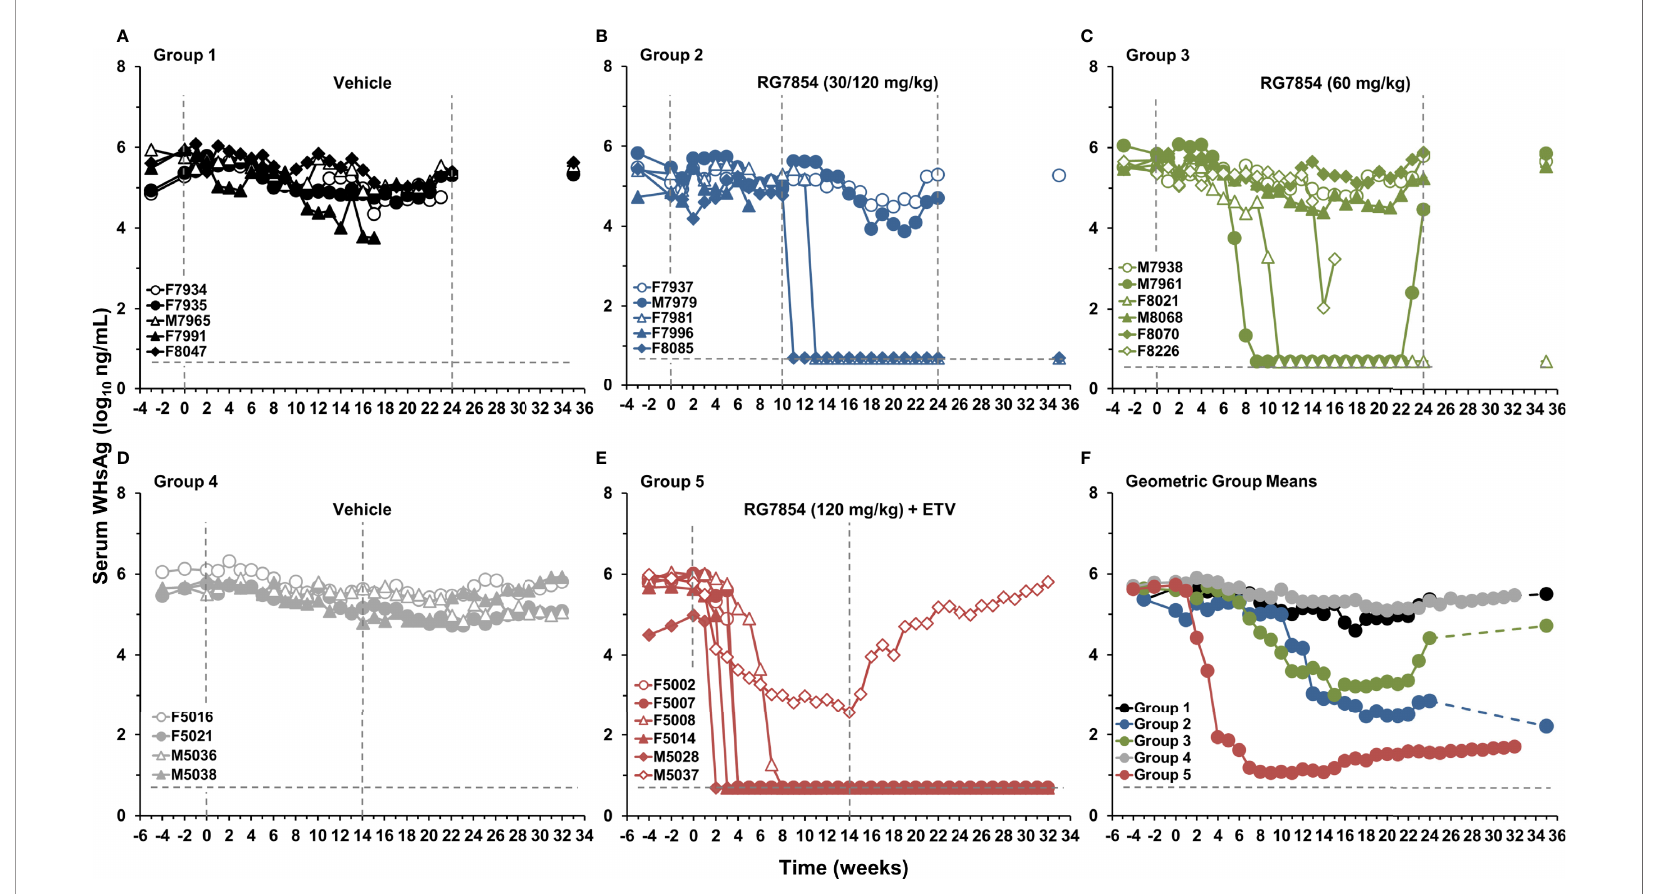
FIGURE 3 | Effect of RG7854, alone and together with ETV, on serum surface antigenemia levels. Kinetics of WHsAg load in individual woodchucks administered (A) placebo or RG7854 at doses of (B) 30/120 mg/kg or (C) 60 mg/kg in the monotreatment study and (D) placebo or (E) RG7854 at a dose of 120 mg/kg plus ETV in the combination treatment study. (F) Geometric group mean WHsAg loads. The horizontal dotted lines indicate the detection limit for WHsAg by quantitative enzyme-linked immunosorbent assay (i.e., 5 ng/mL). The geometric mean WHsAg loads in Group 2 and Group 3 were signi fi cantly reduced compared to Group 1 at T0 and at weeks 1, 6, 7, and 8 or at week 15, respectively ( P < 0.05) (Student ’ s t -test). Compared to Group 4, the geometric mean WHsAg load in Group 5 was signi fi cantly reduced during weeks 4-32 ( P <